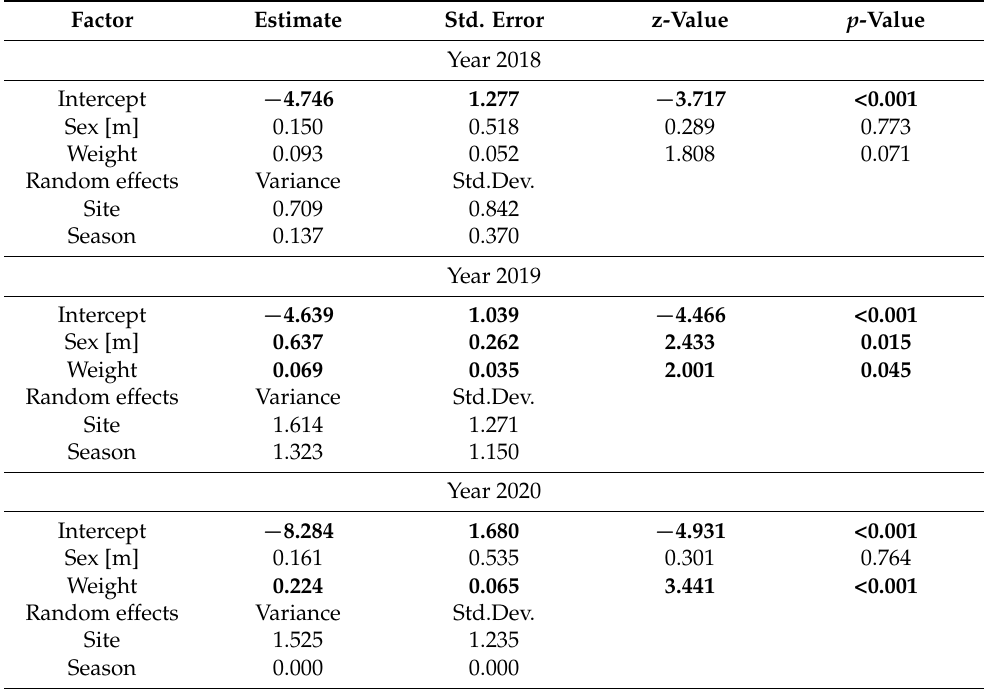
Table 3. Results of generalized linear mixed modelling with binomial error distribution showing the impact of demographic factors on individual infection probability for each